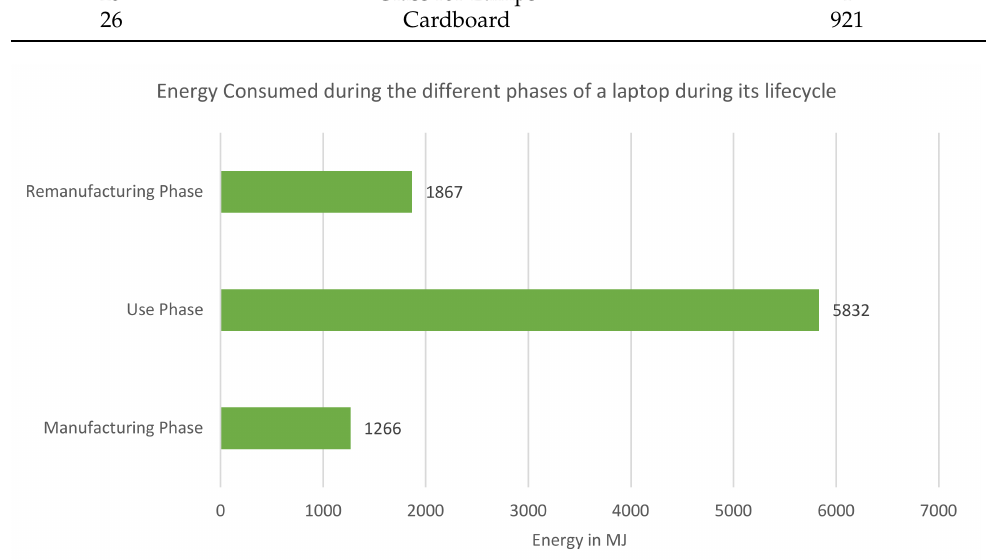
Figure 3. Total energy consumption of a laptop computer over its three